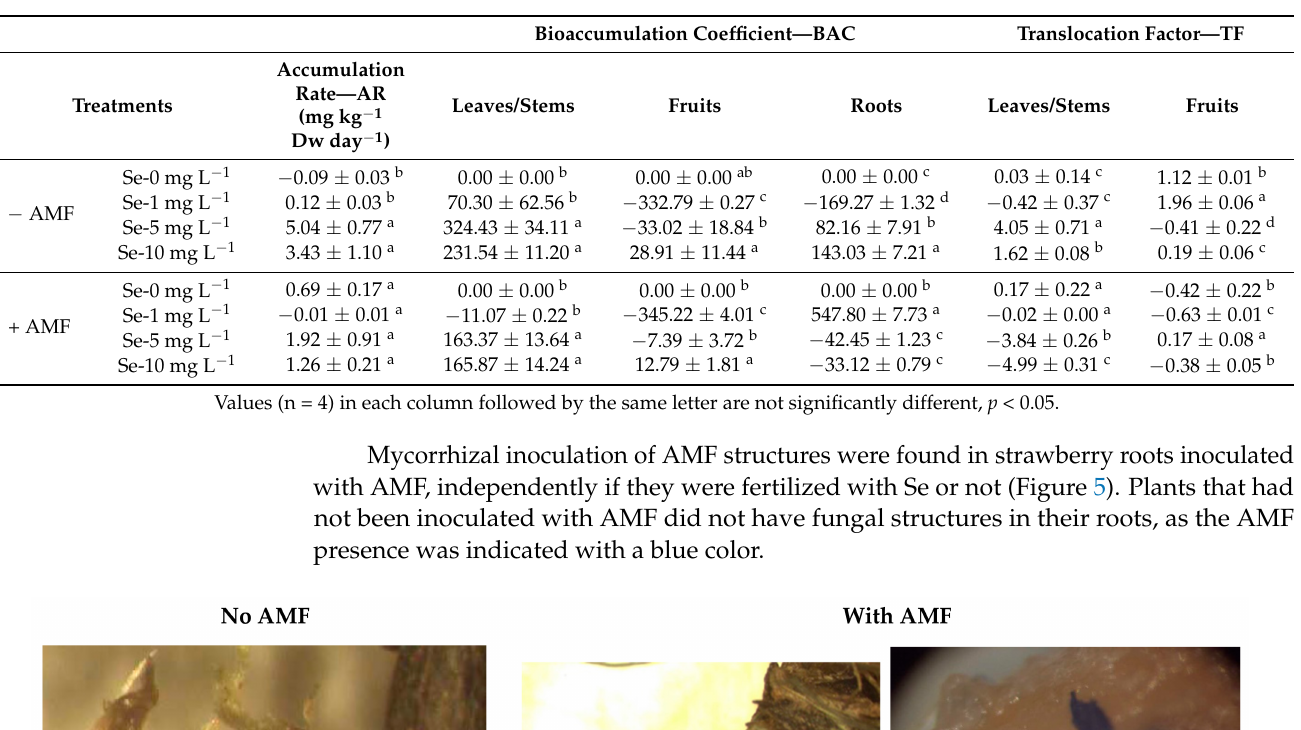
Table 4. Accumulation rate—AR (mg kg − 1 Dw day − 1 ), bioaccumulation coefficient—BAC and translocation factor— TF for Se in strawberry plants grown hydroponically in cocosoil:perlite (4/1 v/v ) with arbuscular mycorrhizal fungi (AMF) inoculation.